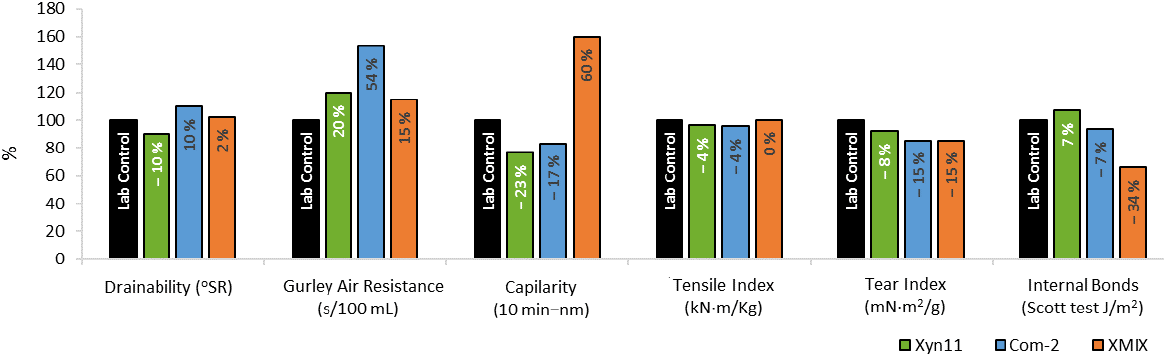
Figure 6. Comparison of pulp brightness obtained after 3 h pretreatment with Xyn11 (green) or without enzyme (control, grey) followed by conventional bleaching sequence applying reference or 15% less ClO 2 loadings; and with 15% less ClO 2 but without EXZ step (No EXZ step, black).